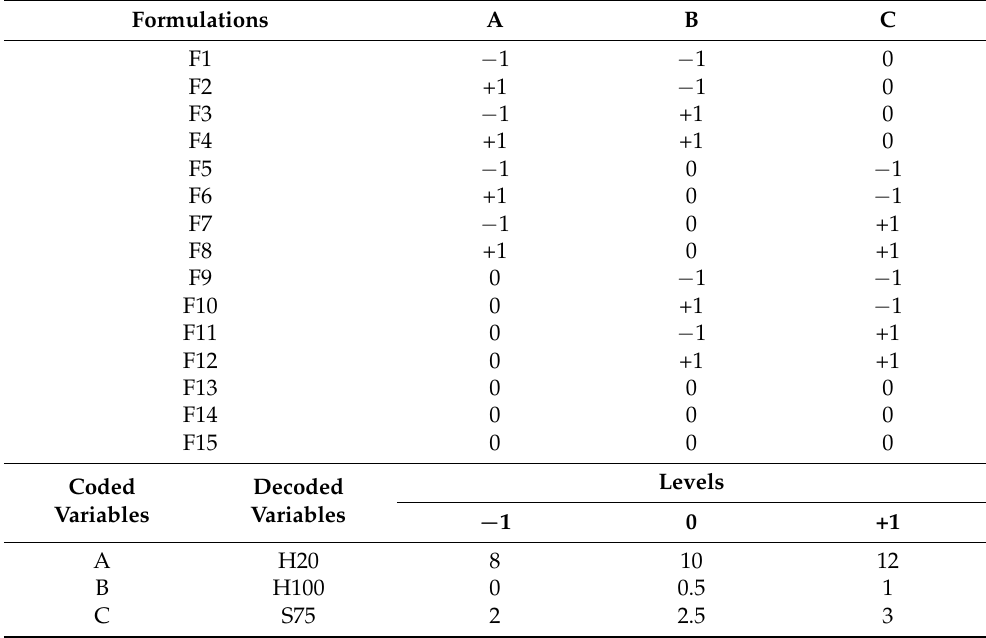
Table 1. Box–Behnken experimental design for Nano-2 development using a combination of phos- pholipids extracted from sunflower (H100 and H20) and soybean (S75).